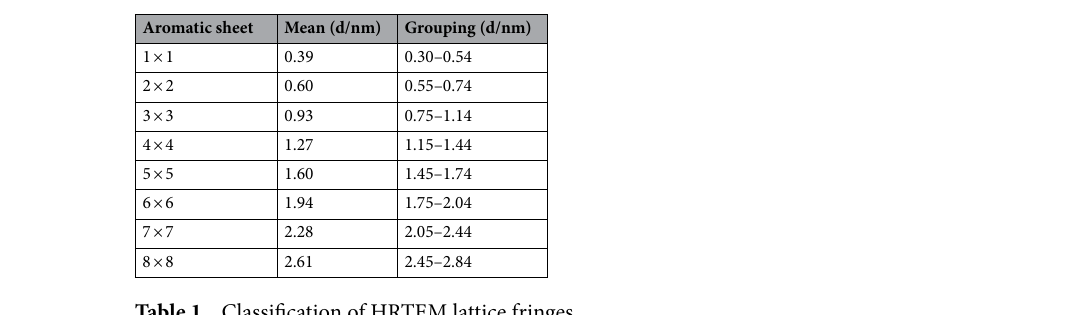
Table 1. Classification of HRTEM lattice